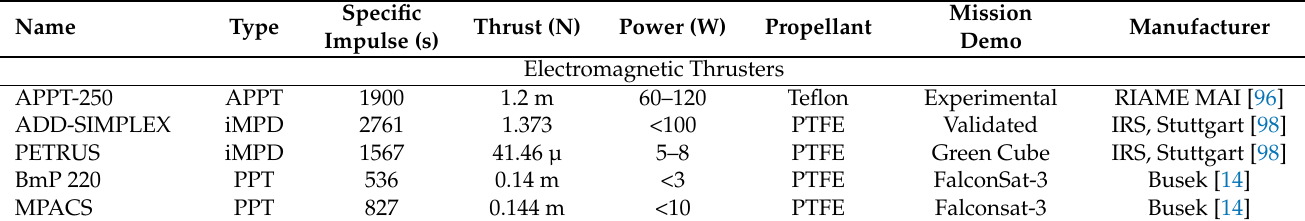
Table 3. Examples of electromagnetic thruster